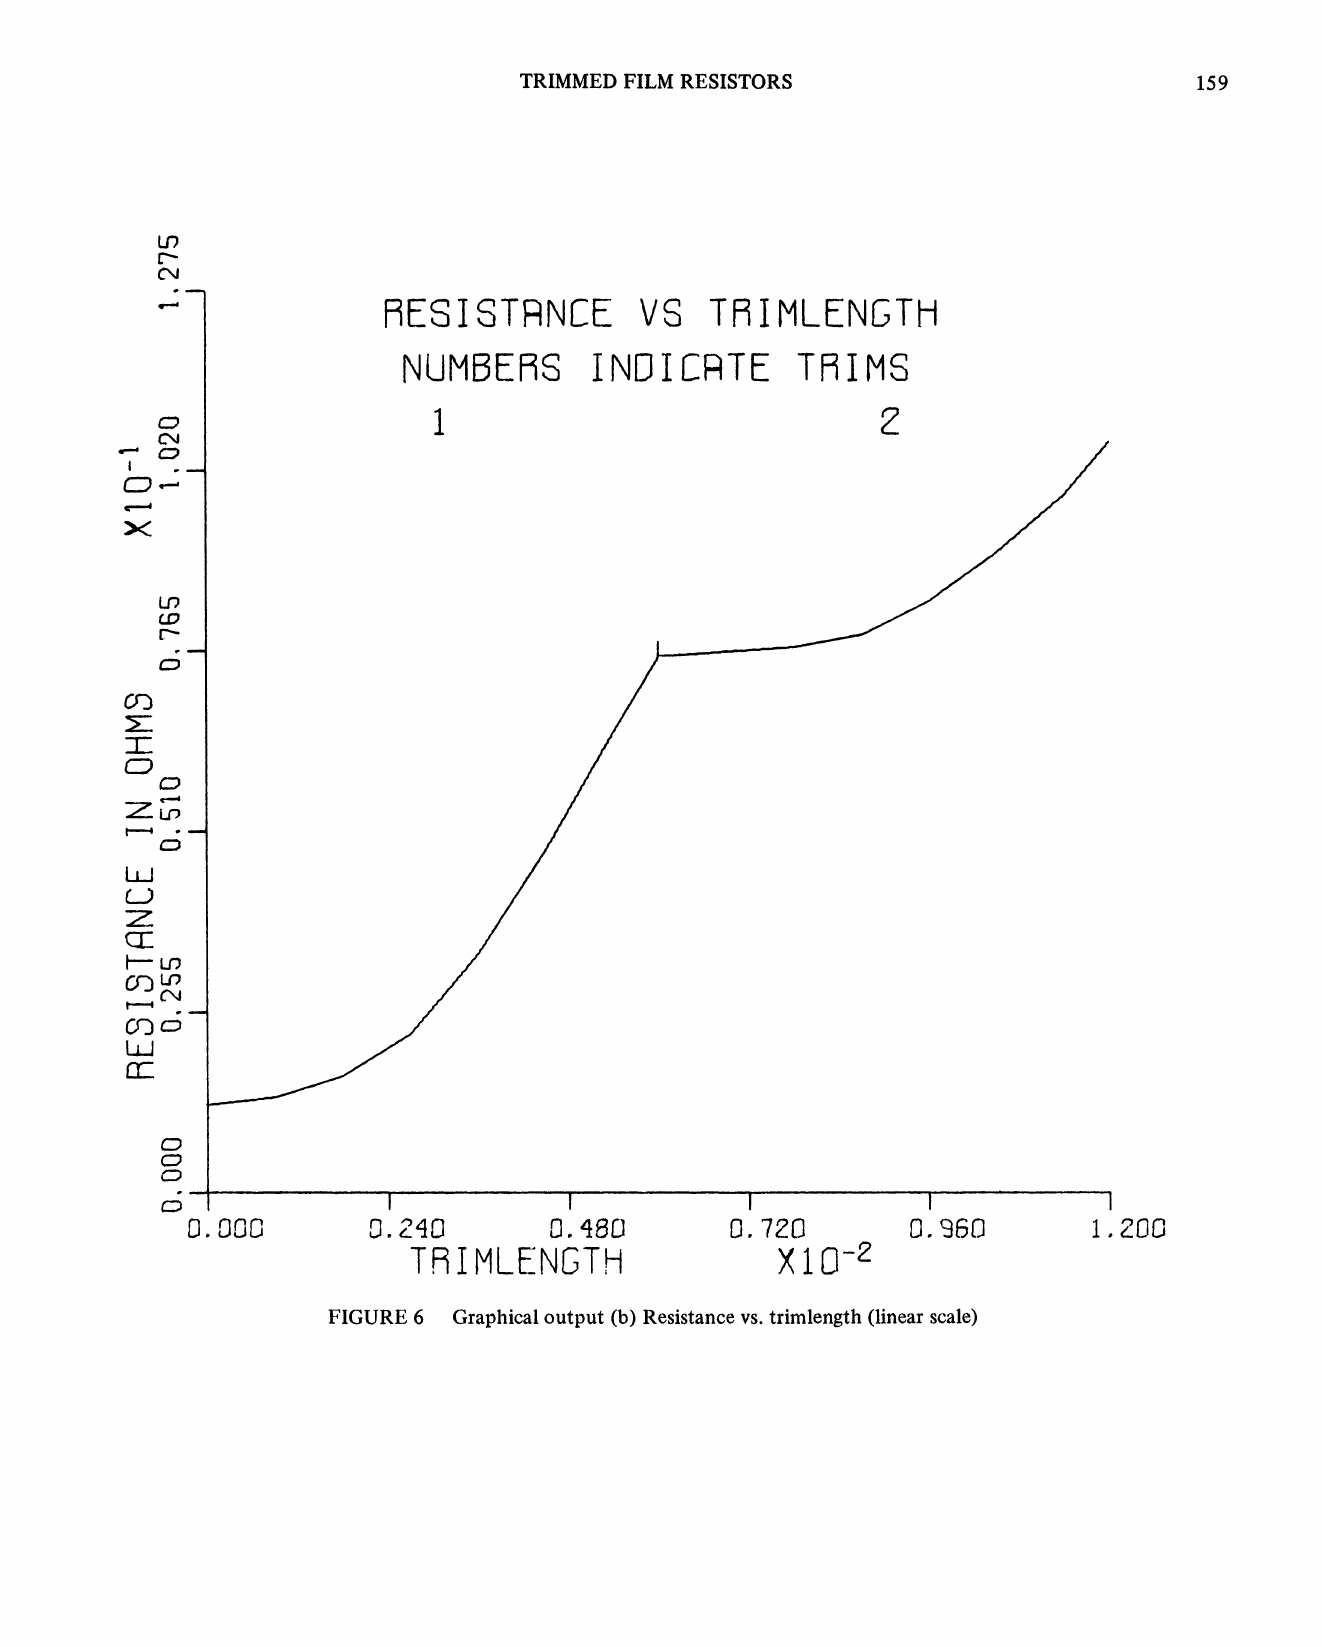
FIGURE 6 Graphical output (b) Resistance vs. trimlength (linear